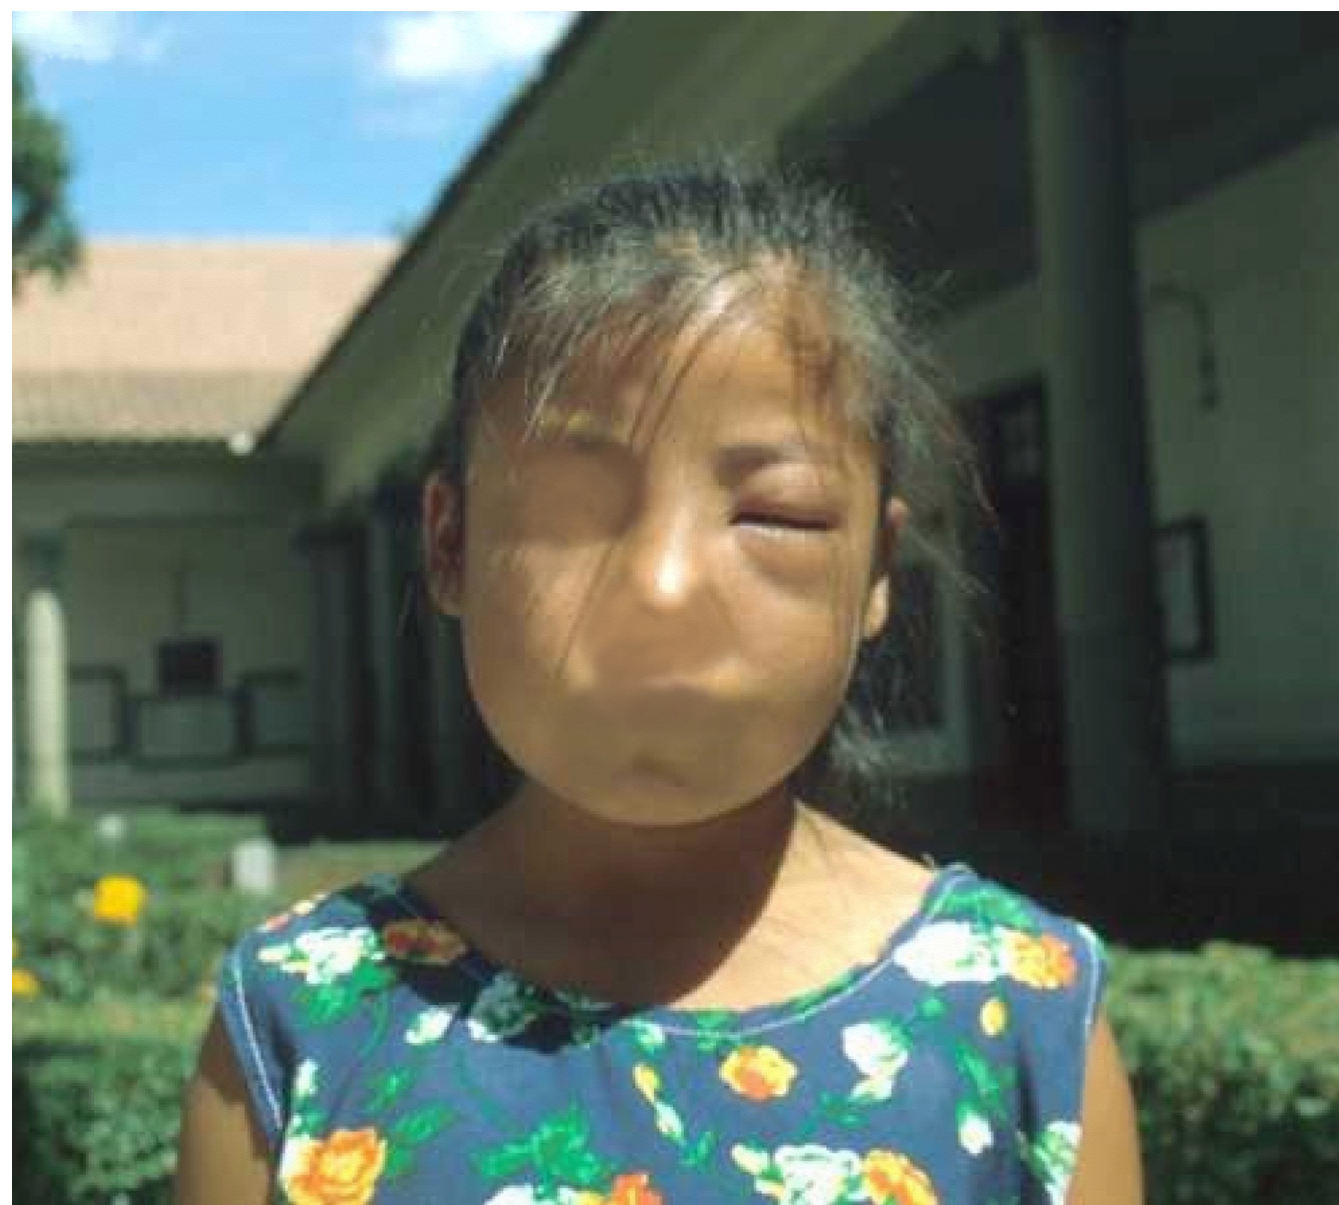
Fig 2. Girl with Roma ñ a’s sign taken in the courtyard of the Faculty of Medicine, Universidad Mayor de San Simo´n, Bolivia around 1980.